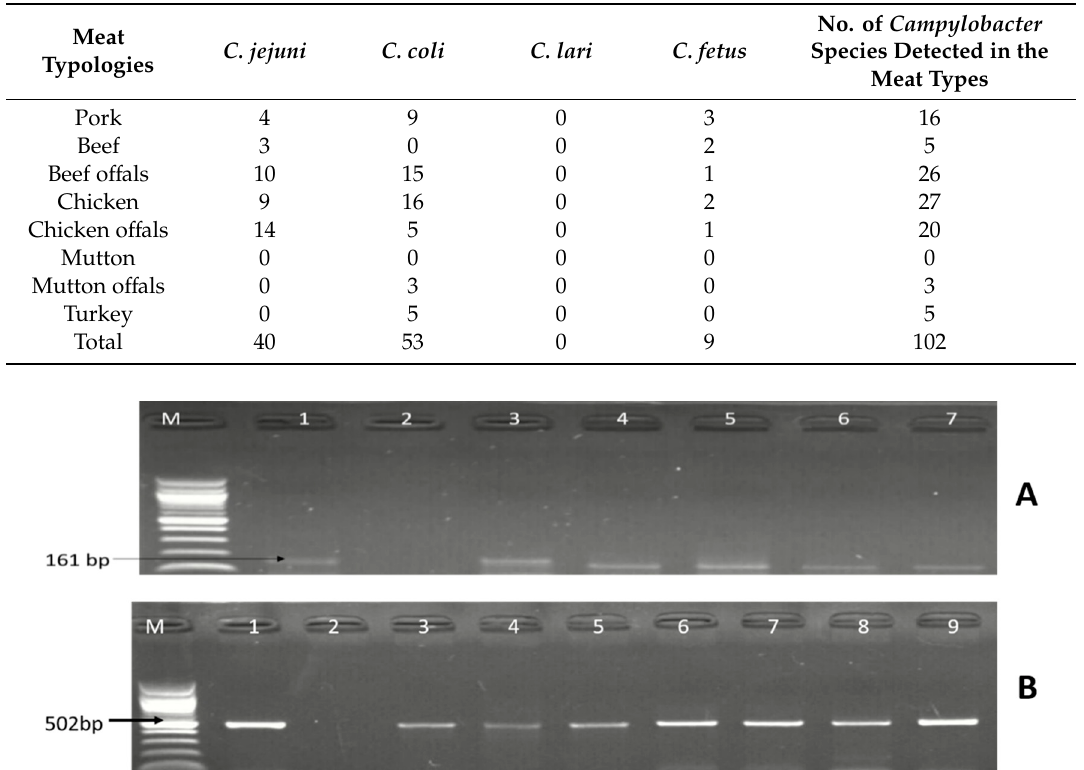
Figure 3. Gel ( A ) is a representative gel electrophoresis image of PCR-confirmed C . jejuni . Lane M: DNA ladder (100 bp); lane 1: positive control ( C. jejuni ATCC 33560); lane 2: negative control; lanes 3–7: positive C . jejuni isolates (161 bp); and ( B ) is a representative gel image of PCR-confirmed C . coli . Lane M: DNA ladder (100 bp); lane 1: positive control ( C. coli ATCC 33559); lane 2: negative control; and lane 3–9: positive C . coli isolates (502 bp).